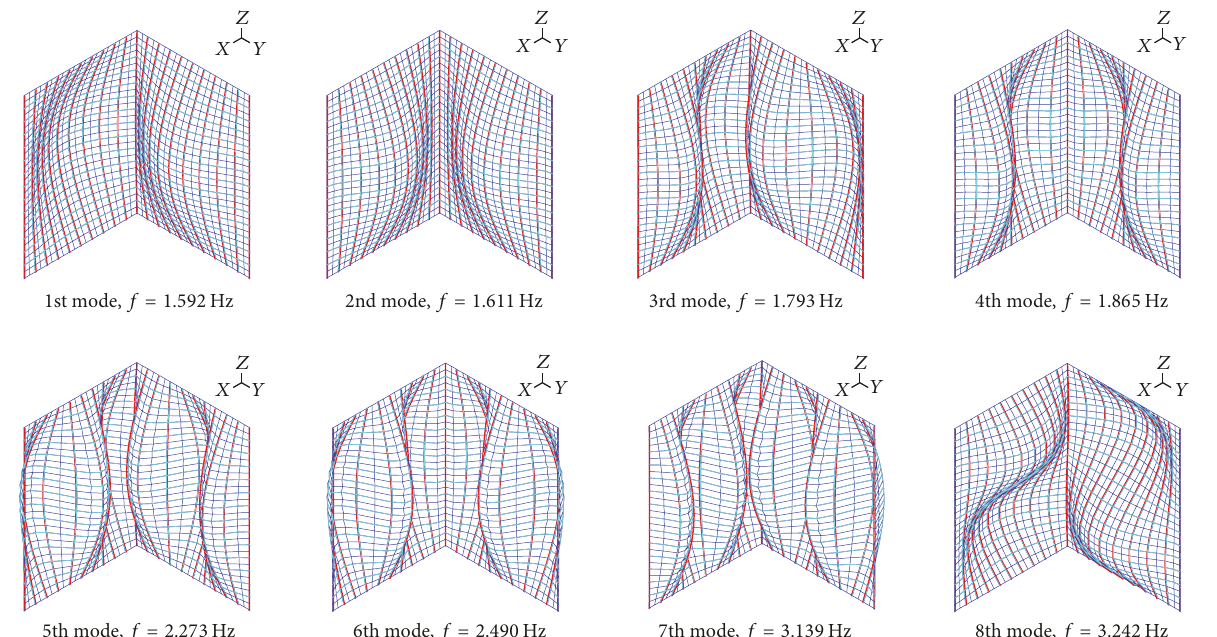
Figure 2: Vibration modes and frequencies of the structure.